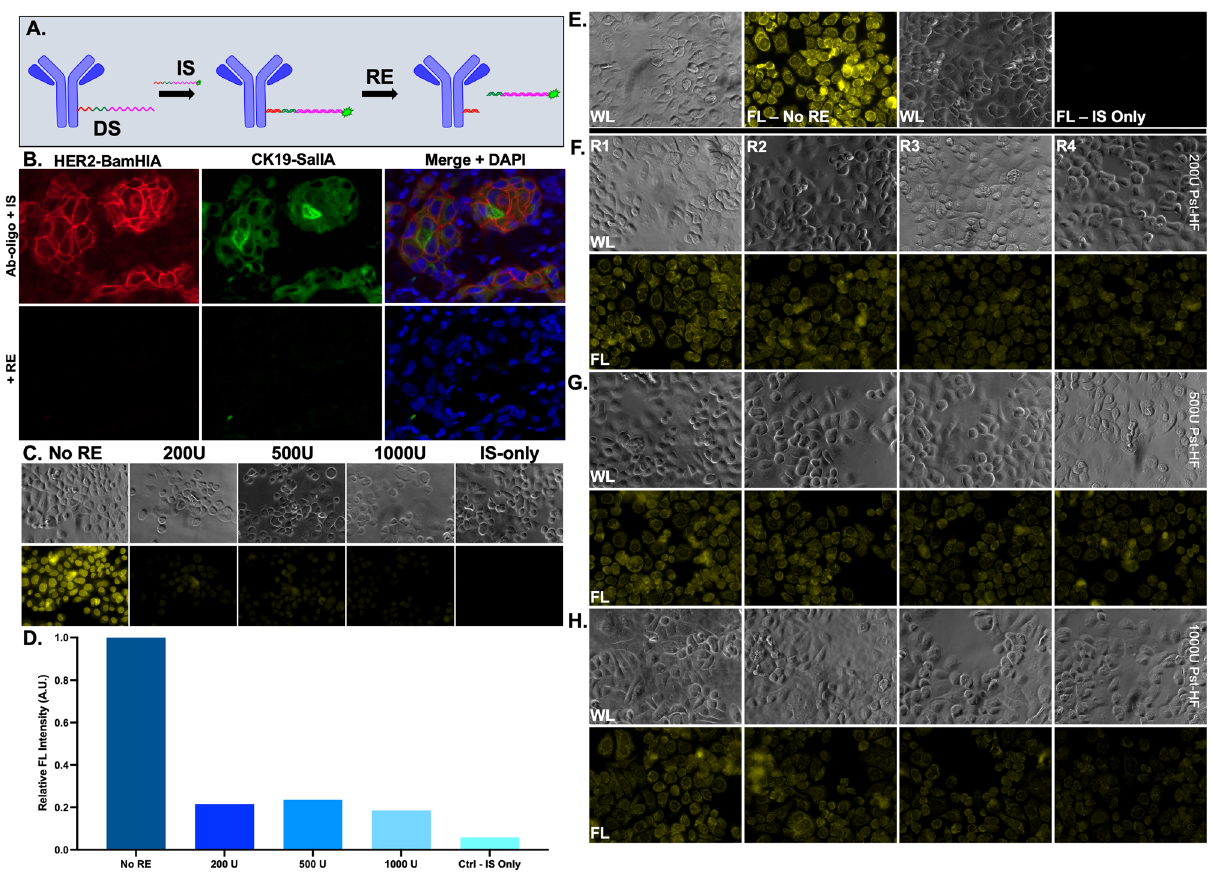
Figure 4. Restriction enzyme signal removal. ( A ) The DS of the Ab-oligo conjugate was designed to contain a region that was recognized by a specific RE once hybridized to its complementary IS for fluorescence signal removal. ( B ) Tissue stained with Ab-oligo conjugates for membrane and cytosolic markers, HER2 and CK19, respectively, had complete signal removal after RE incubation. ( C ) Fluorescence signal from the Lamin B1 Ab-oligo conjugate, an organelle-specific marker, was reduced, ( D ) but remained above background autofluorescence levels (i.e., Ctrl—IS only) after RE incubation at varied concentrations. ( E ) While the Ab-oligo conjugate for TOMM20 showed strong staining (left) compared to IS only control cells (right), fluorescence staining was not removed using ( F ) 200, ( G ) 500 or ( H ) 1000 U of the specific RE (HF PstI) over multiple rounds (i.e., up to four rounds of RE treatment). WL white light, FL